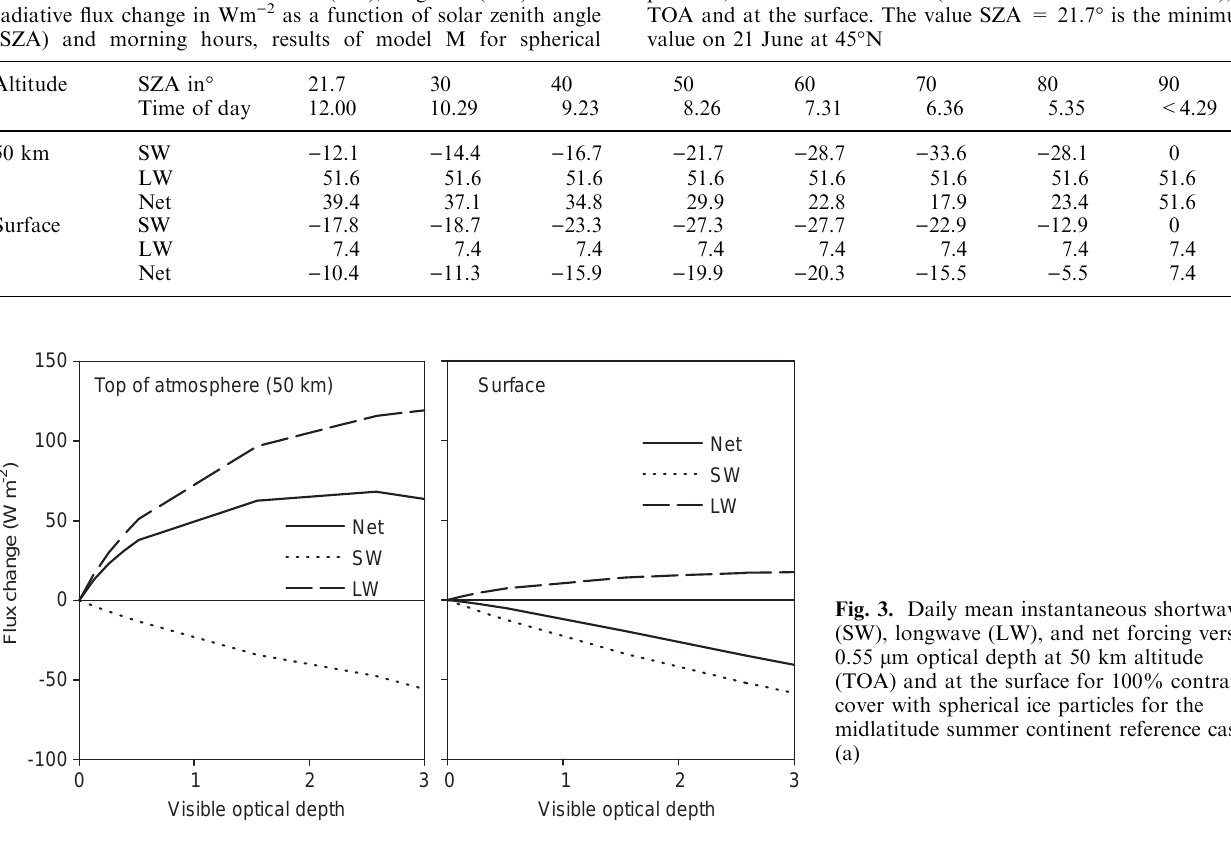
particles, for the reference case (midlatitude summer continent), at TOA and at the surface. The value SZA = 21.7 (cid:176) is the minimum value on 21 June at 45 (cid:176) N